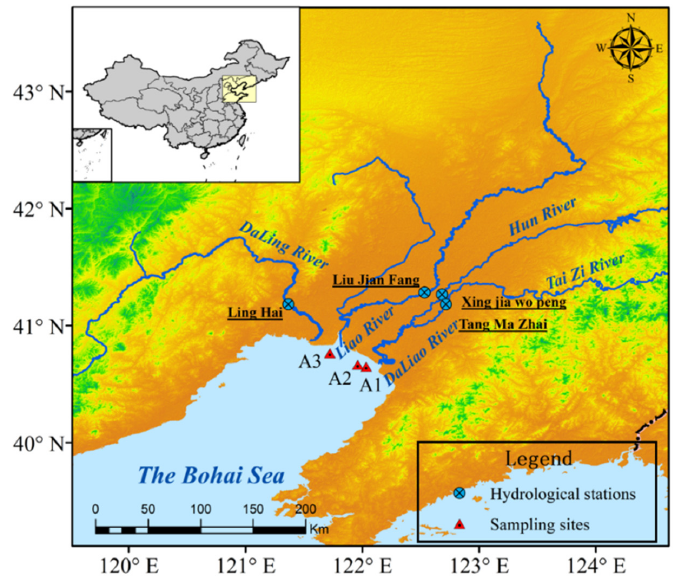
Figure 5. Illustration of Liaodong Bay’s water quality measuring locations.